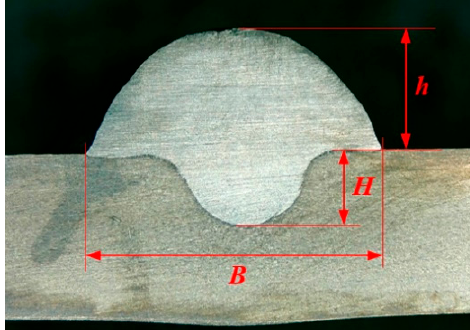
Figure 3. Weld bead geometry and parameters definitions.